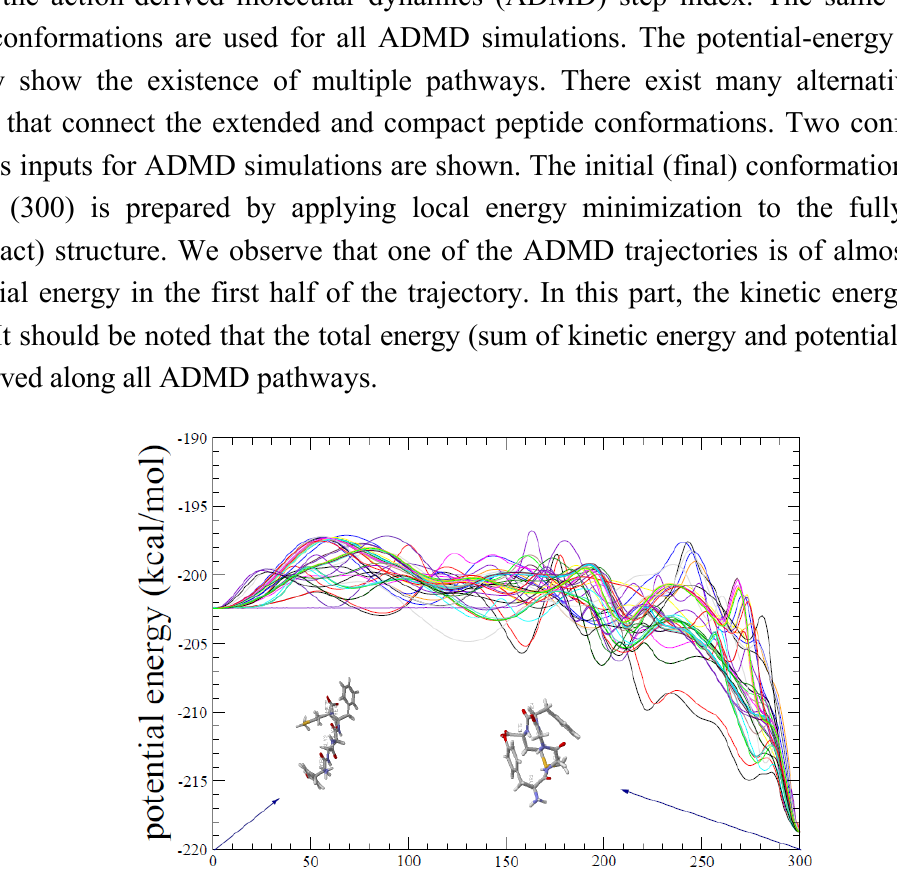
Figure 4. An example for measuring the path quality of a transition path connecting two given configurations is shown. Here, for the pathway generation, Δ = 8.063 fs, N = 75 atoms, and P = 300 are used. Therefore, a total of 3 N ( P − 1) = 67275 scalar “error variables” are used to obtain the distribution